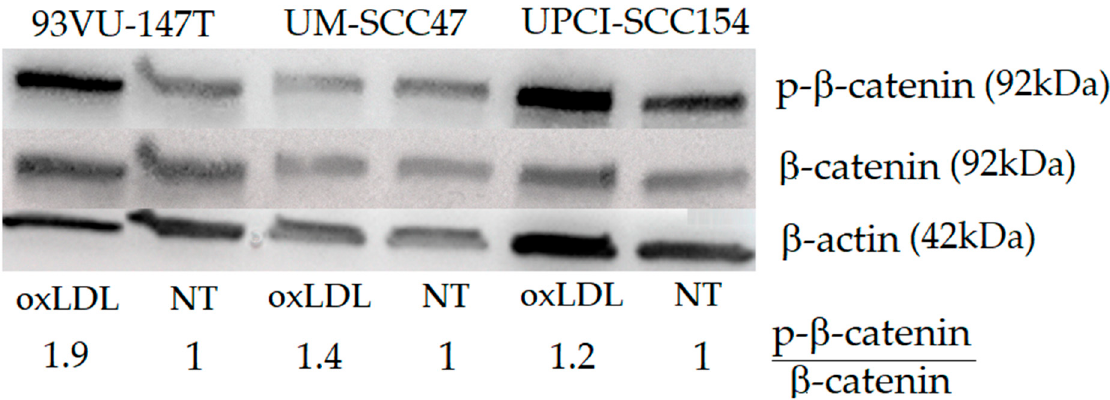
Figure 6. Western blot membrane showing the expression of P-b-catenin, b-catenin, and b-actin with and without oxLDL treatment (30 µg/mL, 48 h). NT = no treatment, cells not exposed to oxLDL.